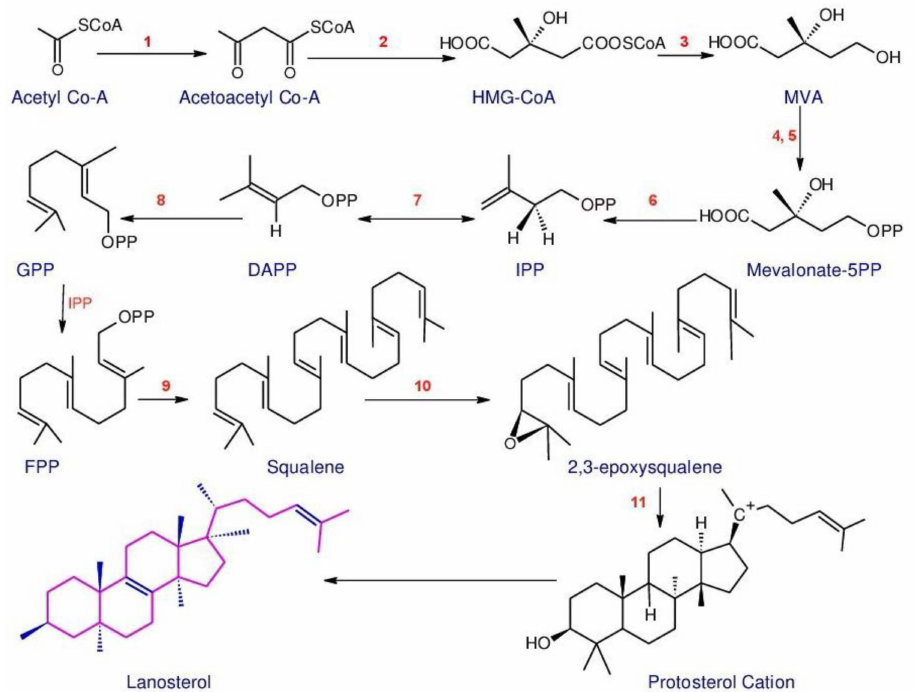
Figure 1. Outline of the MVA and lanostane-type triterpenoids biosynthesis. Enzymes involved in the pathway are: 1. Acetyl-CoA acetyltransferase, AACT; 2. 3-Hydroxy-3-methylglutaryl-CoA synthase, HMGS; 3. 3-Hydroxy-3-methylglutaryl-CoA reductase, HMGR; 4. Mevalonate kinase, MK; 5. Phosphomevalonate kinase, MPK; 6. Phosphomevalonate decarboxylase, MVD; 7. Isopen- tenyldiphosphate isomerase, IDI; 8. Farnesyl diphosphate synthase, FPPs; 9. Squalene synthase, SQS; 10. Squalene monooxygenase, SE; 11. 2,3-Oxidosqualene-lanosterol cyclase, OSC (The structures were redrawn in ACD/ChemSketch: Freeware: